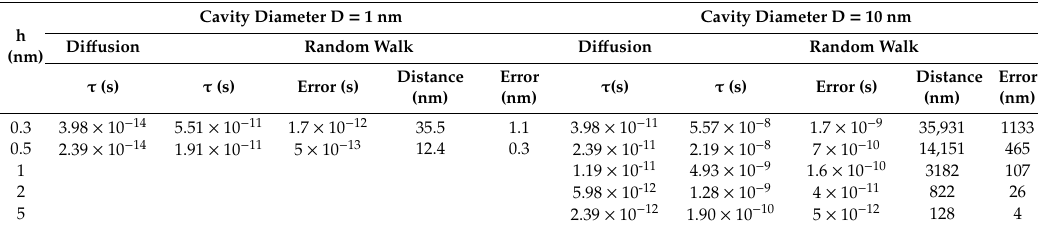
Table A1. Mean escape time ( τ ) of a given molecule, errors and total traveling distance of the confined molecule in a spherical cavity (cavity diameter D of 1 nm and 10 nm) for di ff erent entrance–escape hole diameters (h) calculated by the di ff usion and the non-interactive random walk models.